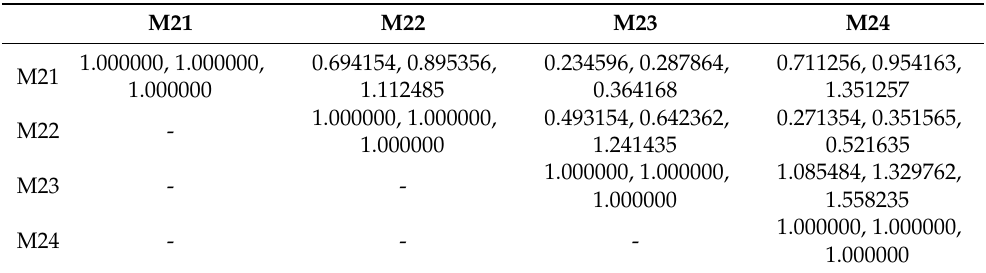
Table 6. Pair-wise fuzzy multi-criteria decision comparative matrix for audit source location.